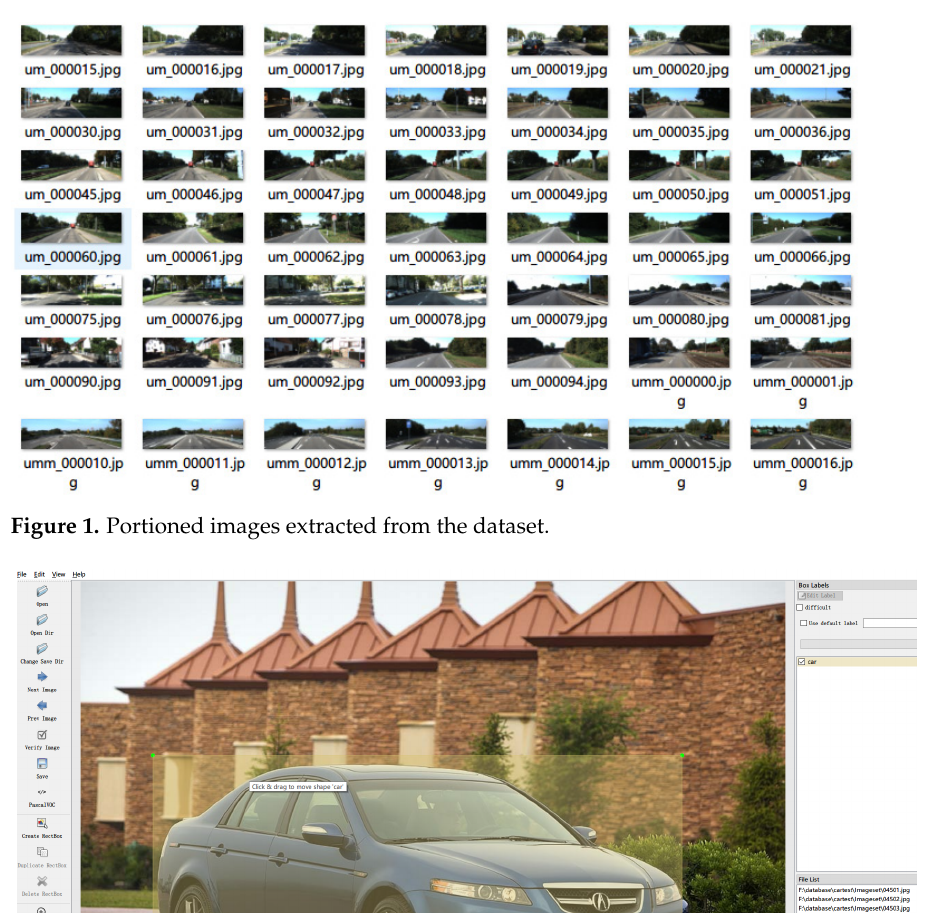
Figure 2. Vehicle identification interface.